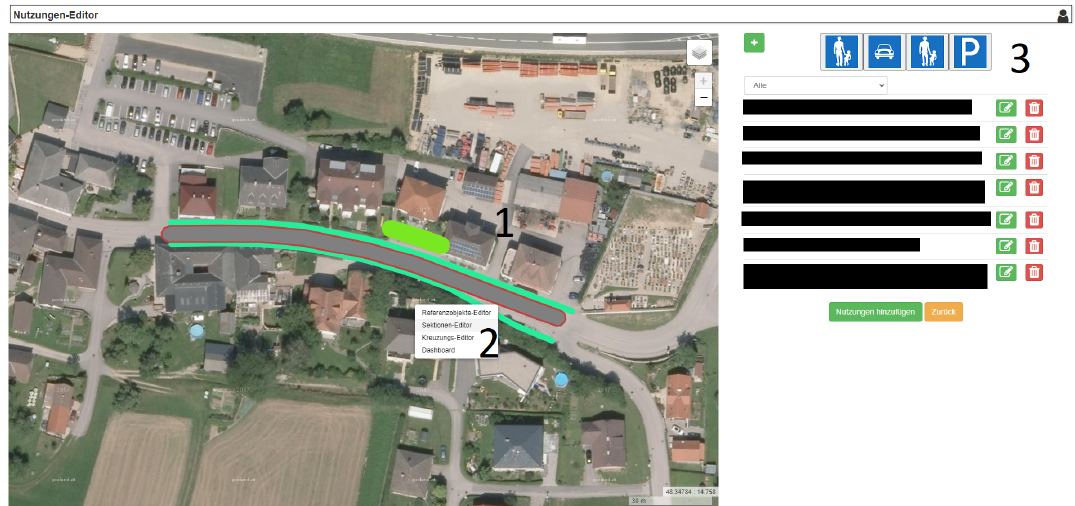
Figure 4. One of the implemented apps of the web application. It is showing the illustration of geodata (1); the easy and intuitive possibility to switch between different apps via context menu (2); an the schematic illustration of data with buttons and pictograms (the information is blackened due to confidentiality reasons)